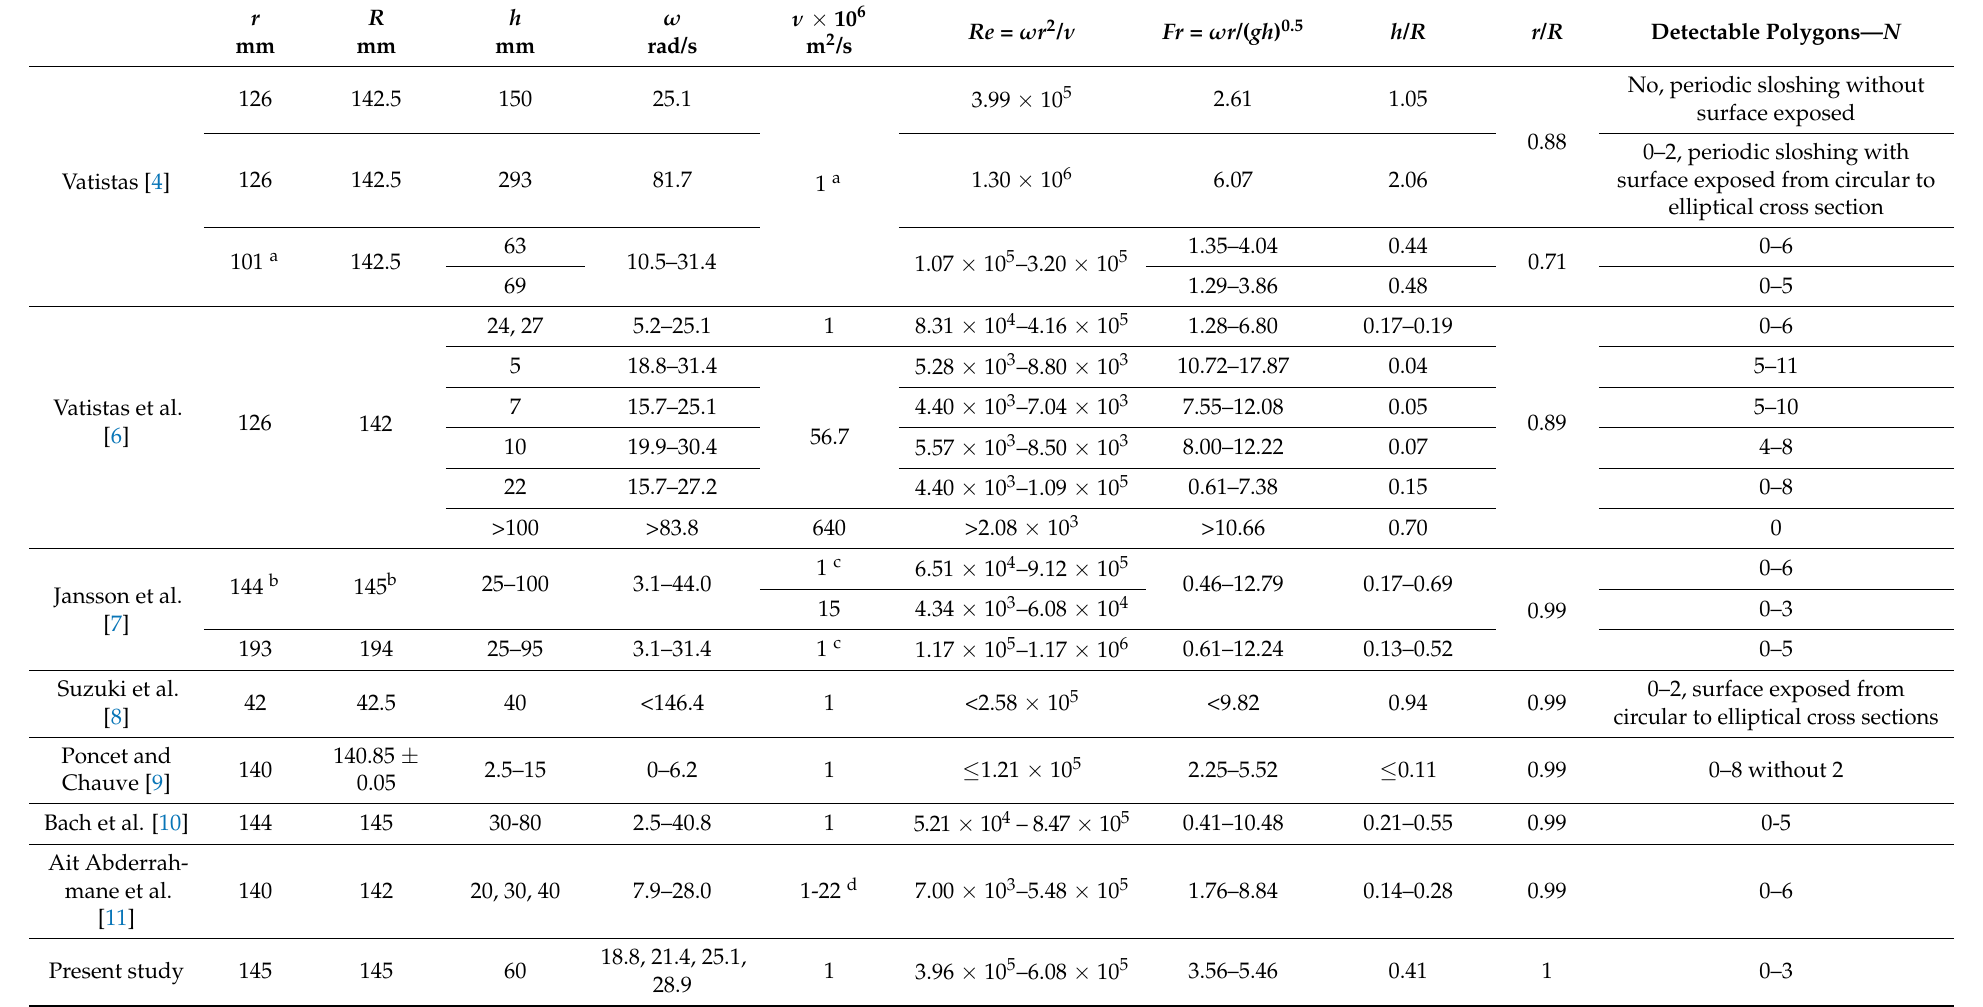
Table 1. Previous experiments and present study: parameters and dimensionless